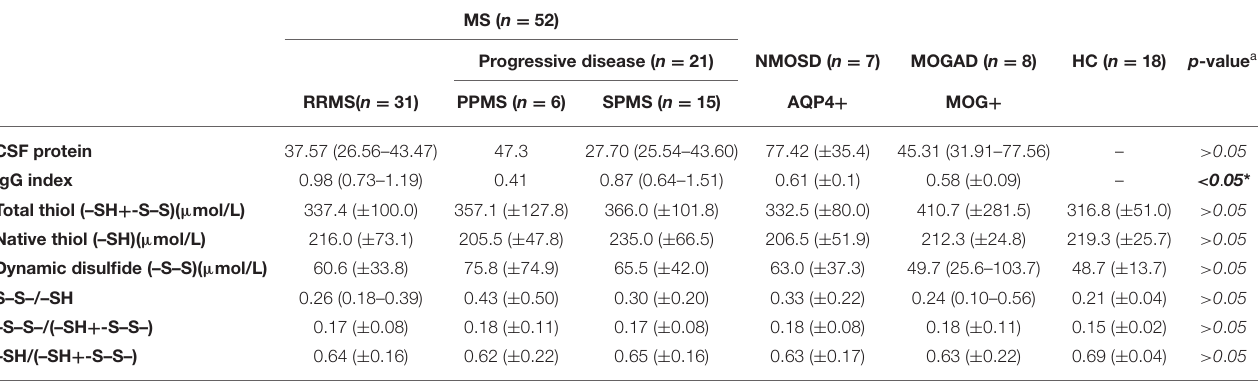
TABLE 2 | Serum biomarker levels in different disease